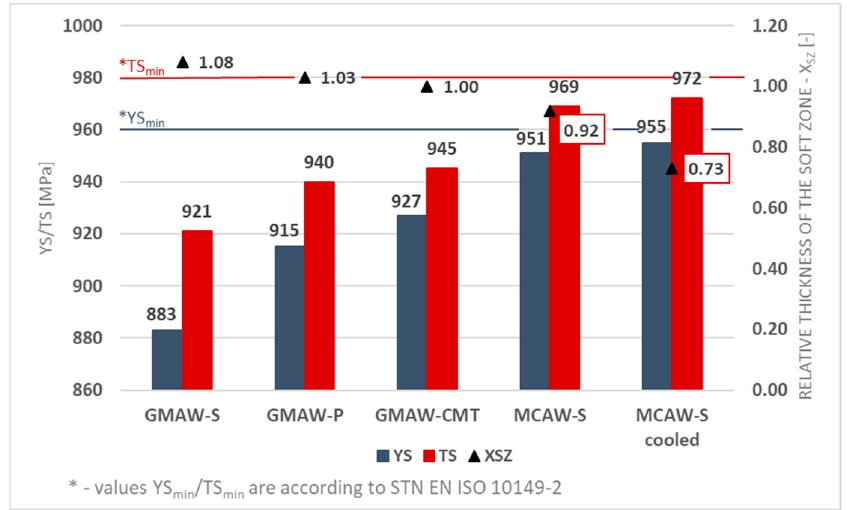
Figure 11. Influence of the relative thickness of the soft zone ( X SZ ) on the yield strength (YS) and tensile strength (TS) of the assessed welded joints.